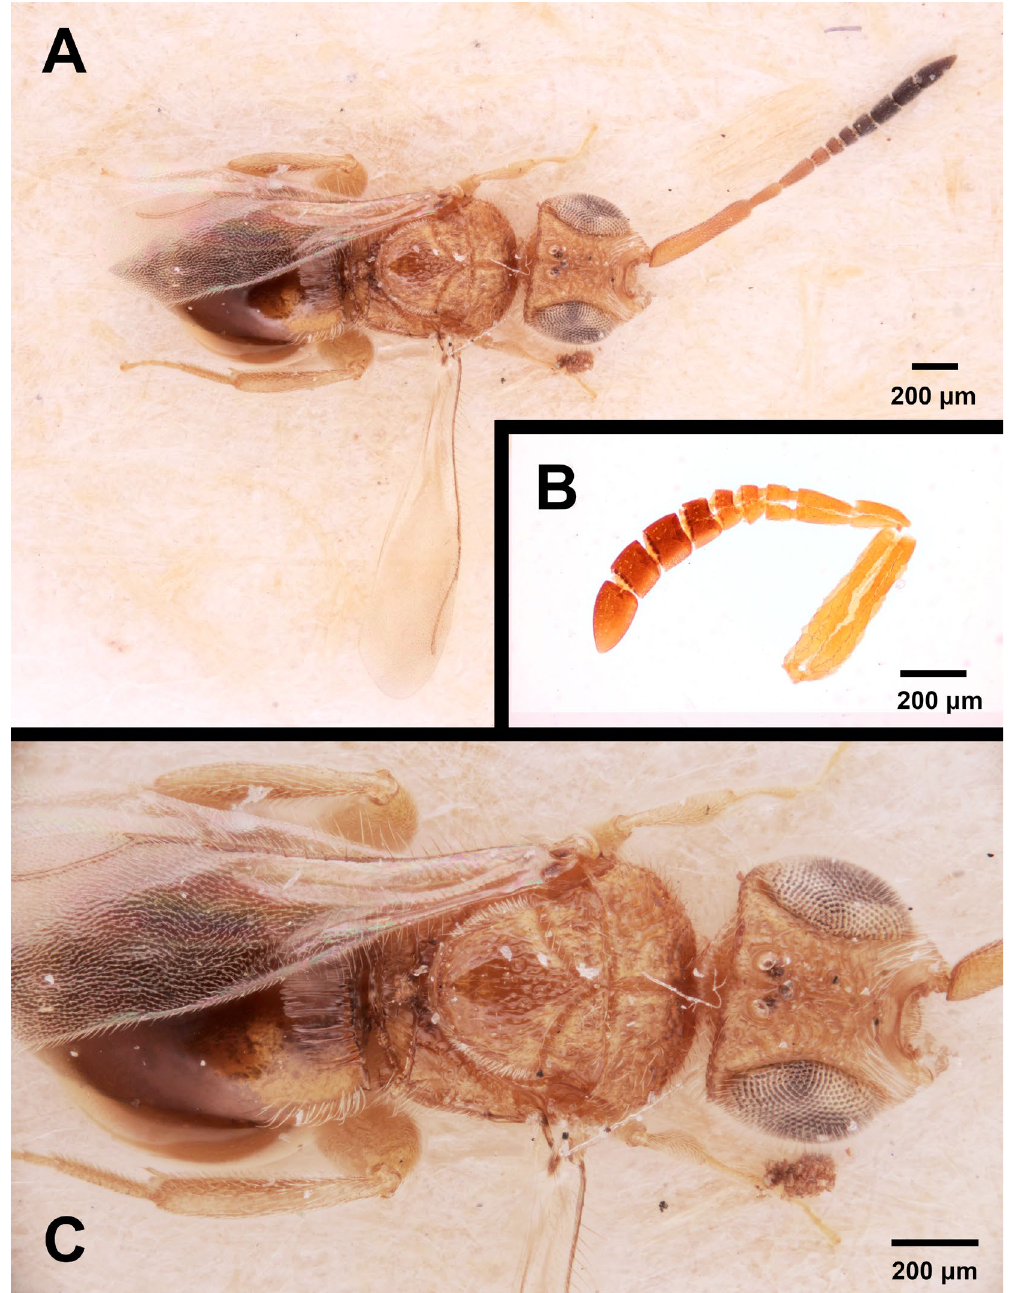
Fig. 10. Ceraphron barbieri Dessart, 1975, allotype, ♀. A . Dorsal view (MNhN EY25349). B . right antenna (MNhN EY22449). C . A closer dorsal view (MNhN